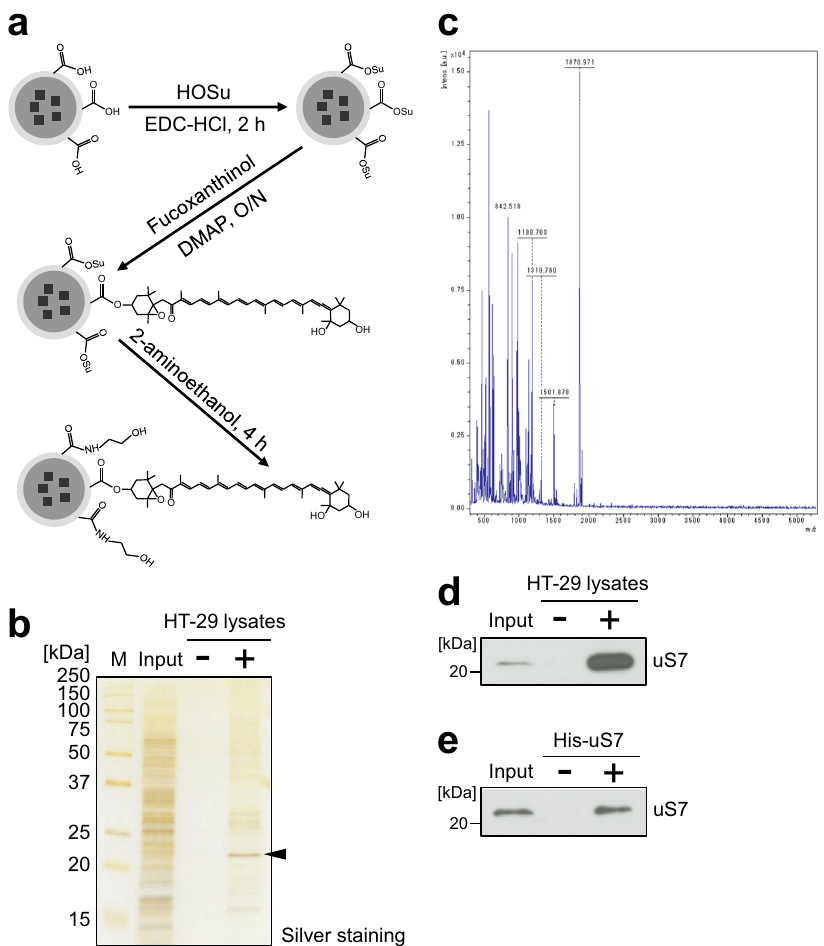
Fig. 2 Ribosomal protein uS7 is the major binding protein of fucoxanthinol. a The scheme for the immobilization of fucoxanthinol onto FG beads ® with carboxyl groups. b Whole-cell extracts of HT-29 cells were incubated with empty ( − ) or fucoxanthinol- fi xed ( + ) FG beads ® , and the binding proteins of fucoxanthinol were puri fi ed and detected by silver staining. c The major binding protein indicated by an arrowhead in b was analyzed by mass spectrometry, and the molecular masses of the peptides detected are shown. d Whole-cell extracts of HT-29 cells were incubated with fucoxanthinol- fi xed beads, and the binding of uS7 was detected by western blotting. e The recombinant His-tagged uS7 protein (His-uS7) was incubated with fucoxanthinol- fi xed beads, and the binding of uS7 was detected by western blotting. HOSu: N -hydroxysuccinimide, EDC-HCl: 1-ethyl-3-(3-dimethylaminopropyl)- carbodiimide hydrochloride, DMAP: